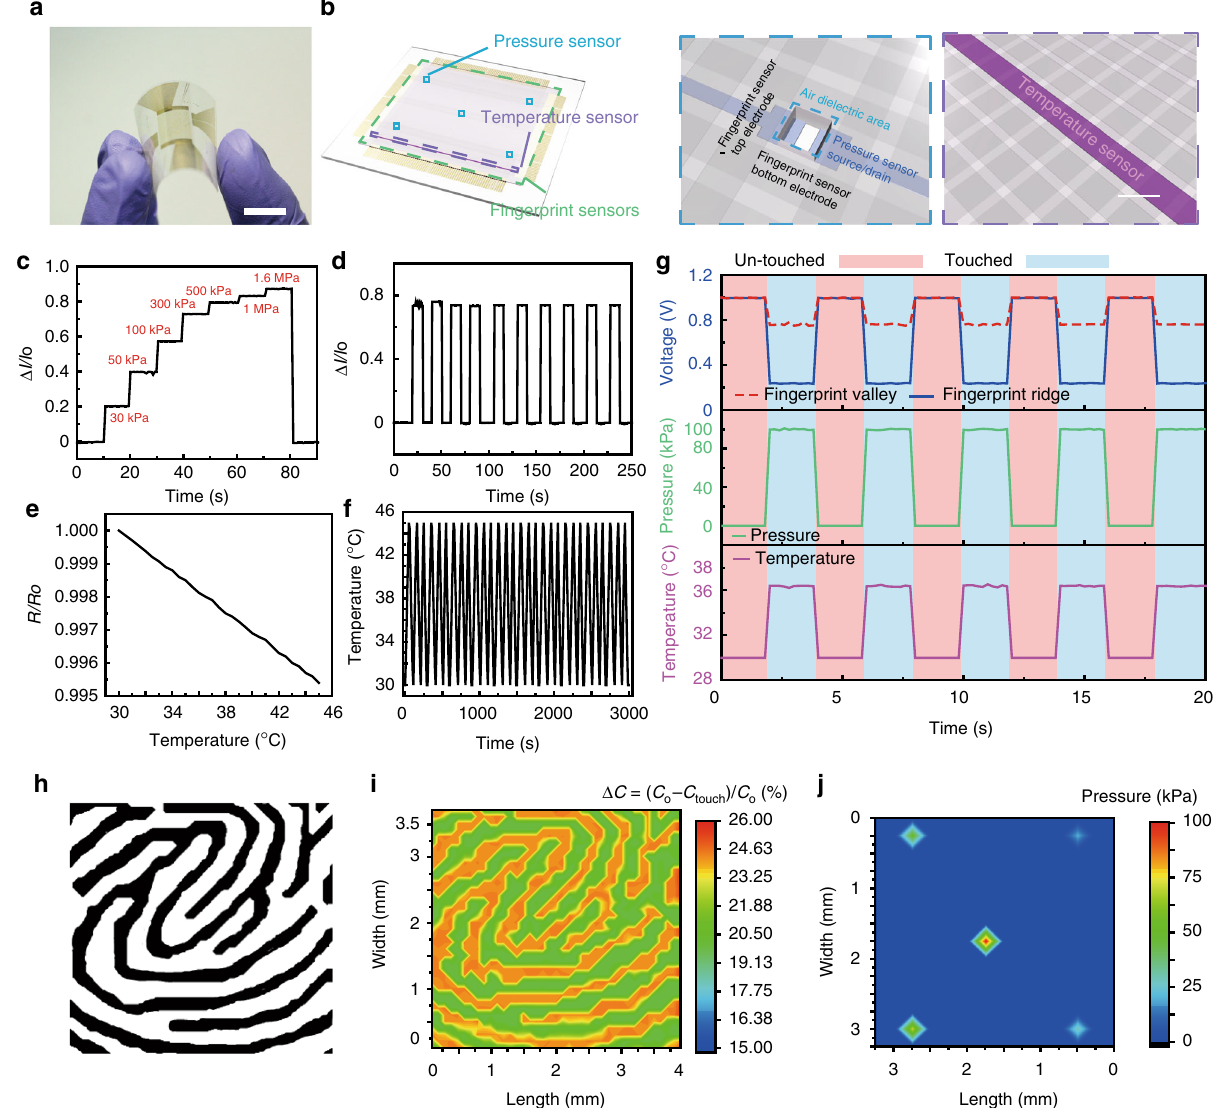
Fig. 5 Fully integrated multiplexed fi ngerprint sensor. a Optical micrograph multiplexed fi ngerprint sensor. Scale bar, 1 cm. b Schematic illustration of a multiplexed fi ngerprint sensor. c , d Real-time measurements of normalized drain current changes for applied pressure at V D = 10 V and V G = 30 V. Different amounts of pressure are applied one by one, sequentially representing step-like features ( c ). Pressure (100 kPa) is loaded and unloaded repeatedly to evaluate stable and reliable operation ( d ). e Temperature versus normalized resistance. f Temperatures (30 – 45 ℃ ) are loaded and unloaded 30 times to evaluate stable and reliable operation. g Real-time sensing graph of the multifunctional fi ngerprint sensor array. h Scan image of the real fi ngerprint. i Two-dimenstional (2D) mapping image of the relative changes in the capacitance of the fi ngerprint sensor upon the touch of human fi nger. j Color gradation contour plot of the resultant signals ( Δ I D / I o ) detected from fi ve different pressure sensors by the single touch of a fi